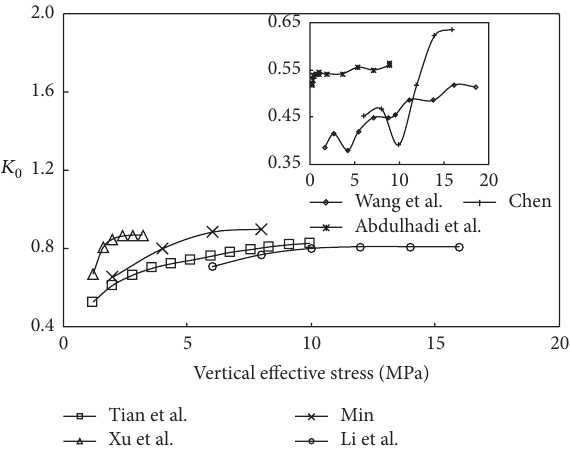
Figure 6: Schematic of the effect of end